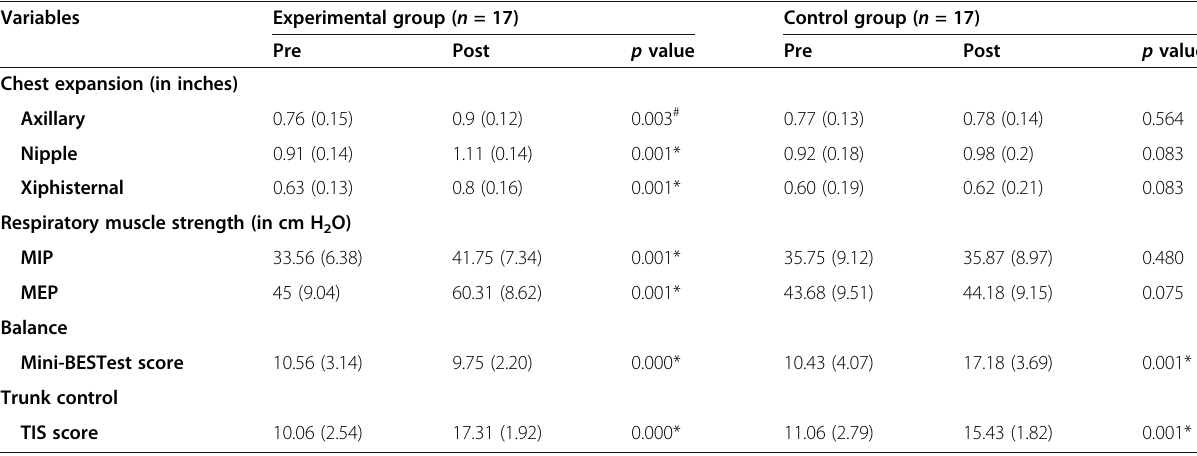
Table 2 Intra-group comparison of chest expansion, respiratory muscle strength, mini-BESTest score, and TIS in the experimental and control